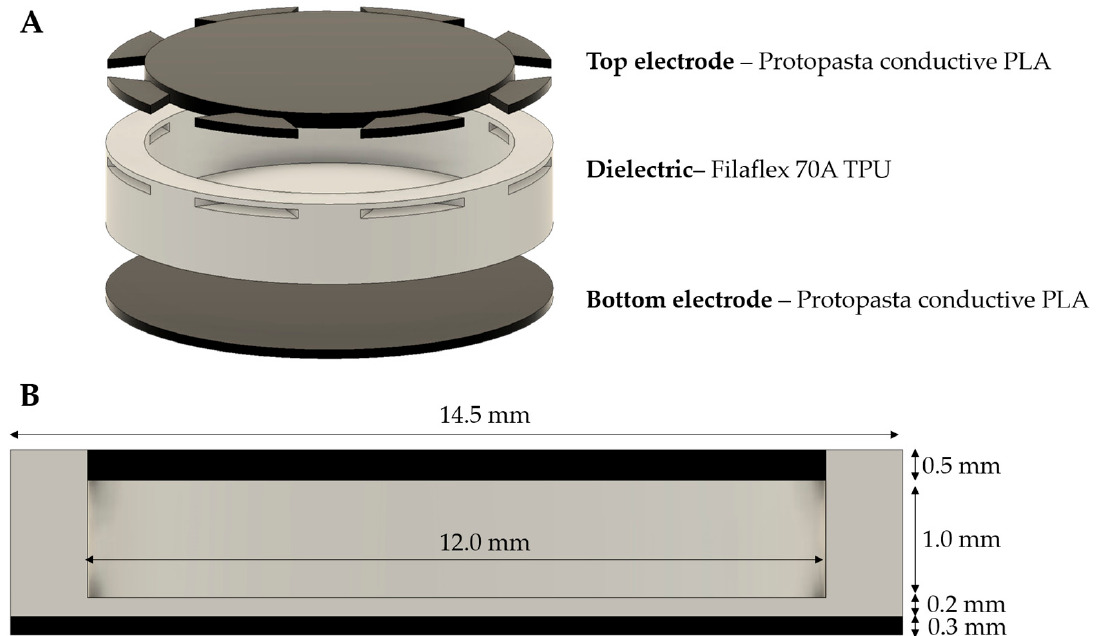
Figure 1. ( A ) Layers of the structure and ( B ) cross-section of the 3D-printed capacitive pressure sensor. plates made of Protopasta CDP11705 composite conductive PLA (Protoplant, Vancouver, Canada) while the middle dielectric layer is made of Filaflex 70A TPU (Recreus Industries S.L., Elda, Spain) (Figure 1). The overall thickness of the sensor is t = 2 mm and its diameter d = 14.5 mm with layers of the following thicknesses: bottom electrode— 0.3 mm, top electrode—0.5 mm and dielectric in total—1.2 mm. The settings for the 3D printing of the different materials used for the fabrication of the capacitive pressure sensors are